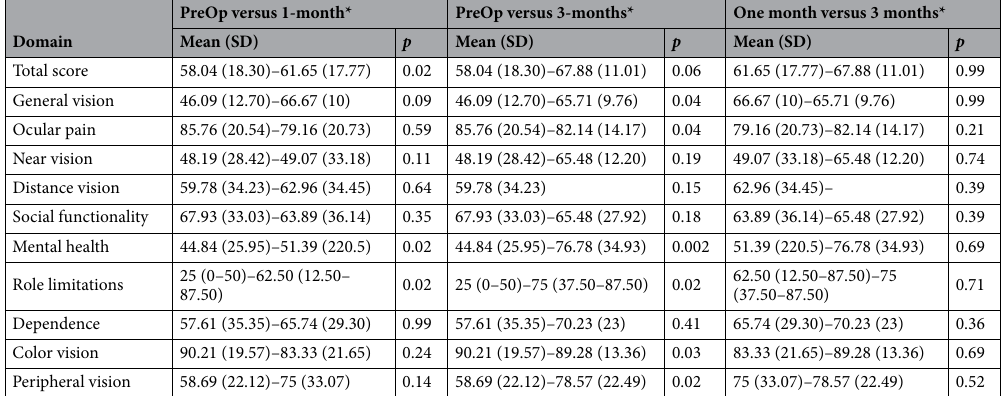
Table 2. Comparison of quality-of-life related variables of pre-and post-surgical evaluations, in rhegmatogenous retinal detachment. PreOp Preoperative. *Paired student’s t-test.